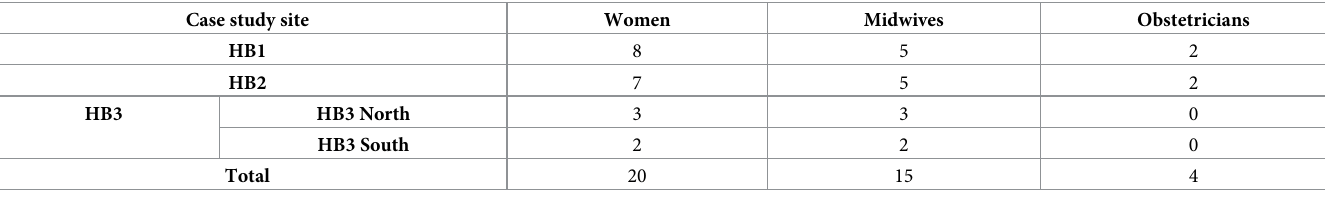
Table 2. Number of women and healthcare professionals recruited in each NHS health board. Case study